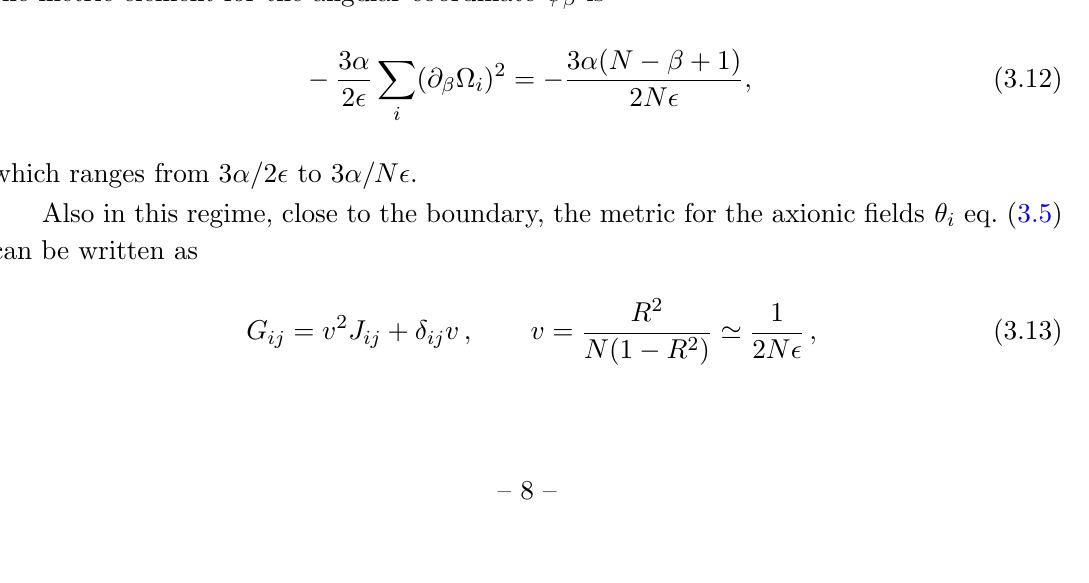
, with angles (cid:18) and ’; 1 f g = 1 and A = 0 : 2. The bottom- 1 2 . The bottom-right plot i = 1 and A = 0 : 2. We can see that the elliptical structure 1 2